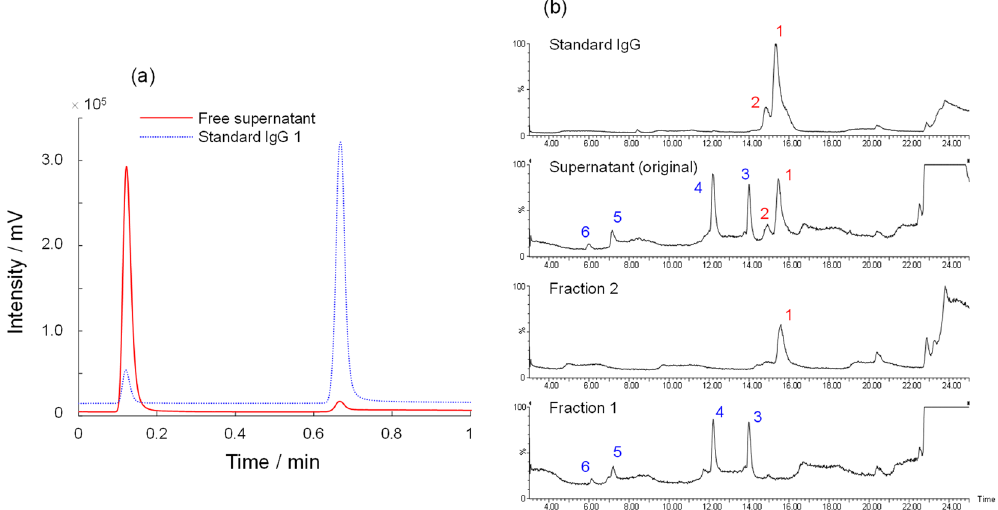
Figure 5. Affinity separation of cell supernatant for isolation of IgG. ( a ) UV chromatograms of a supernatant in a protein A load sample and a standard IgG 1 with the ProA-SpM. ( b ) Total ion chromatograms in